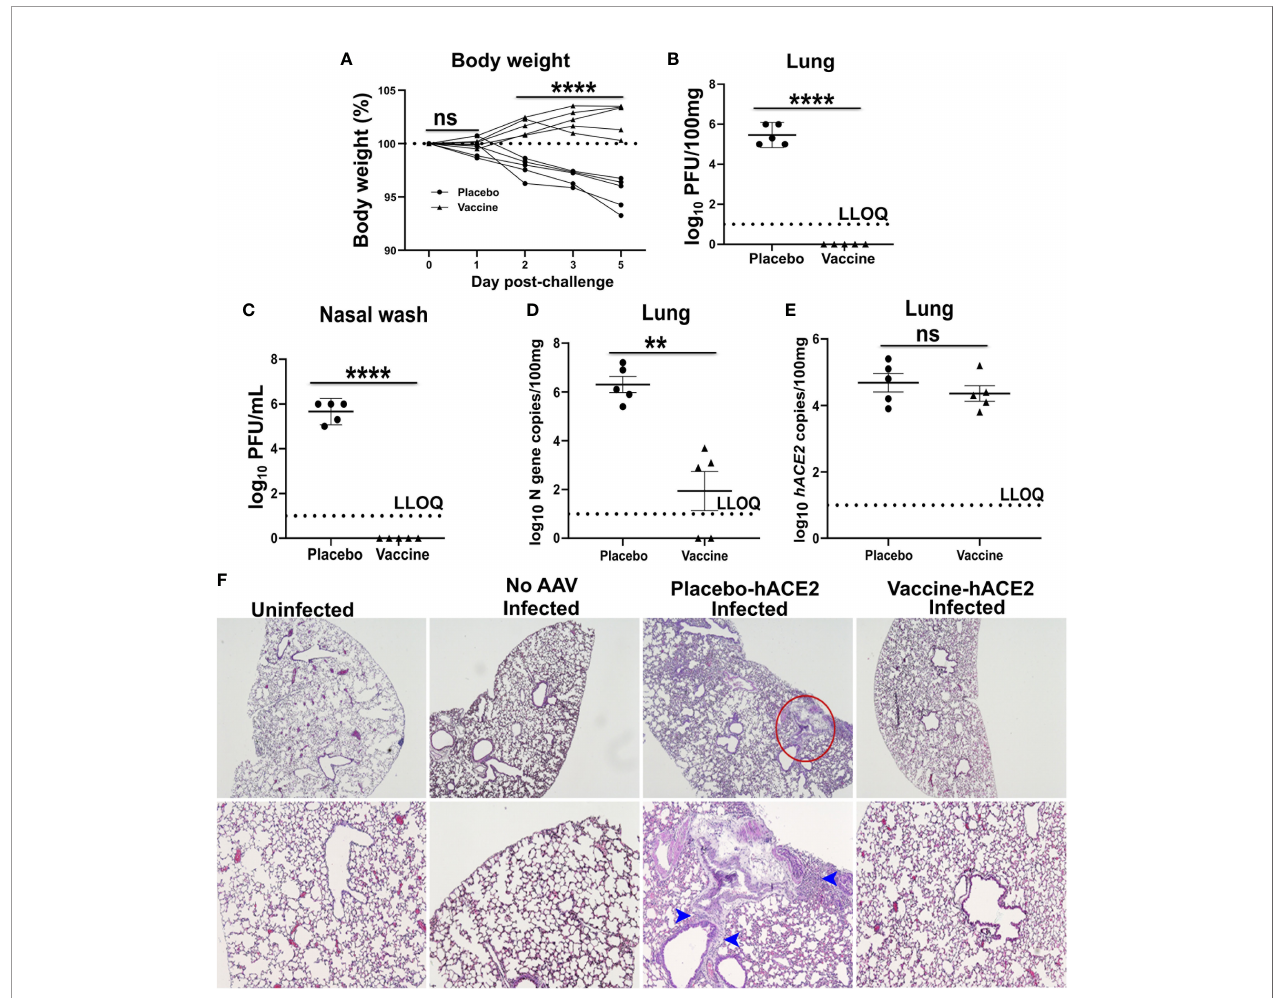
FIGURE 3 | Demonstration of protection by an oral mRNA vaccine candidate. Male mice were immunized with 1 × 10 8 CFU orally twice at two weeks interval and challenged intranasally with SARS-CoV-2 delta variant three weeks later. Mice were administered AAV-hACE2 4 days before the challenge infection. (A) Body weight was monitored for fi ve days following challenge. Each line represents one individual mice. Live virus in (B) lung and (C) nasal wash was measured by a plaque assay. (D) SARS-CoV-2 N gene and (E) hACE2 copies in lung was measured by qRT-PCR. Dashed line in (B – E) represents lower limit of quanti fi cation (LLOQ). (F) H & E stained lung tissue sections. Red circle indicates the area of interstitial pneumonia and blue arrowheads denote the lymphocytic in fi ltrate. Data information: Protection data was derived from fi ve biologically independent mice per group. Data presented as mean ± SEM at 95% CI. Data in (A) was analyzed by two-way ANOVA using S ̌ ı ́ da ́ k ’ s multiple comparisons test. Data in (B – E) was analysed by Mann Whitney test. **p < 0.01, ****p < 0.0001 and ns p >